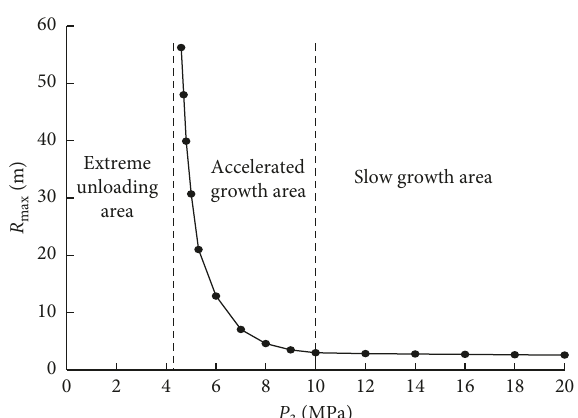
Figure 6: Relationship between the maximum radius of plastic zone and minimum confining pressure.